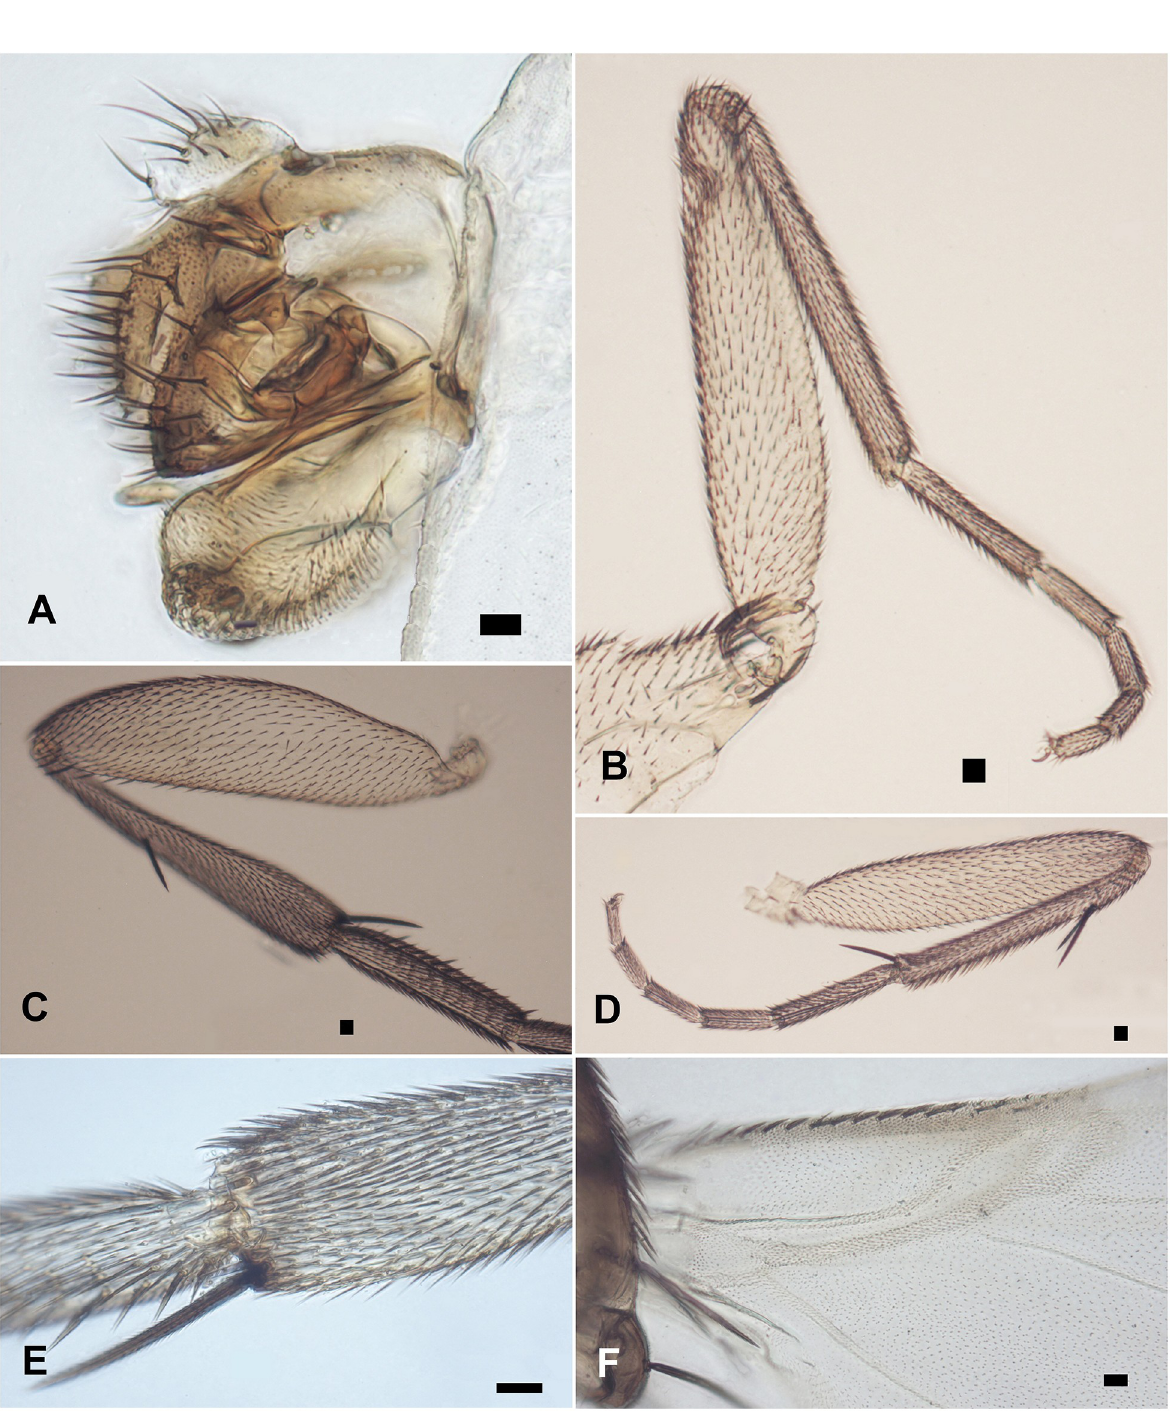
Fig 1. Mahabadphora aesthesphora n. gen, n. sp., male. A, whole fly; B, frons; C, side of thorax; D, antennae, palps, and proboscis; E, abdomen; F, left face of hypopygium. The right black rectangle of each image represents a scale of 20 μ m.